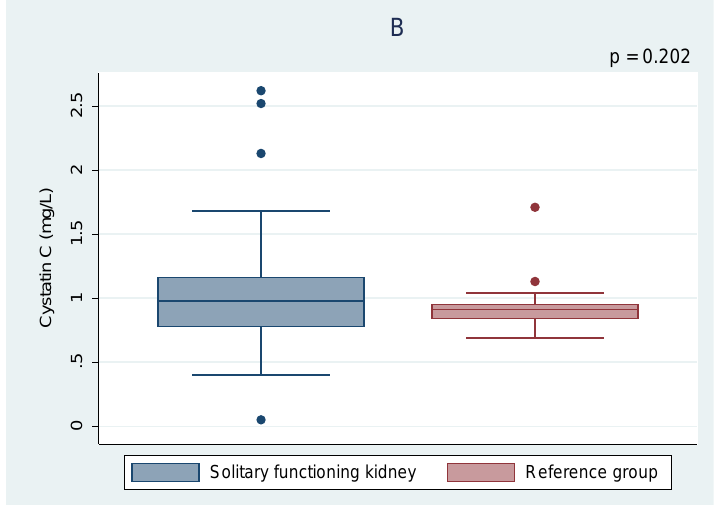
Figure 1. Comparison of the galectin-3 ( A ) and cystatin C ( B ) levels between the children with solitary functioning kidney and the reference group.